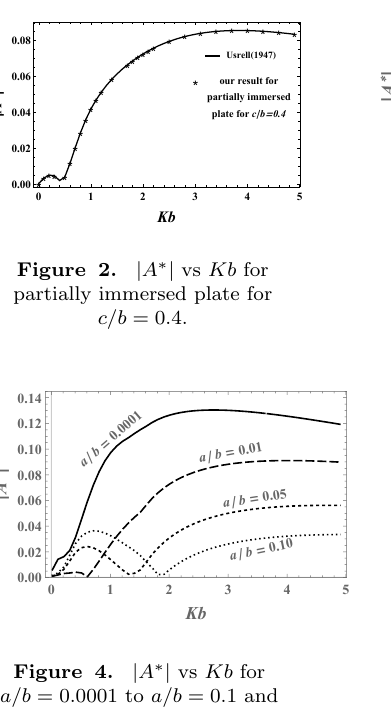
Figure 4. | A ∗ | vs Kb for a/b = 0 . 0001 to a/b = 0 . 1 and c/b = 0 . 5 .